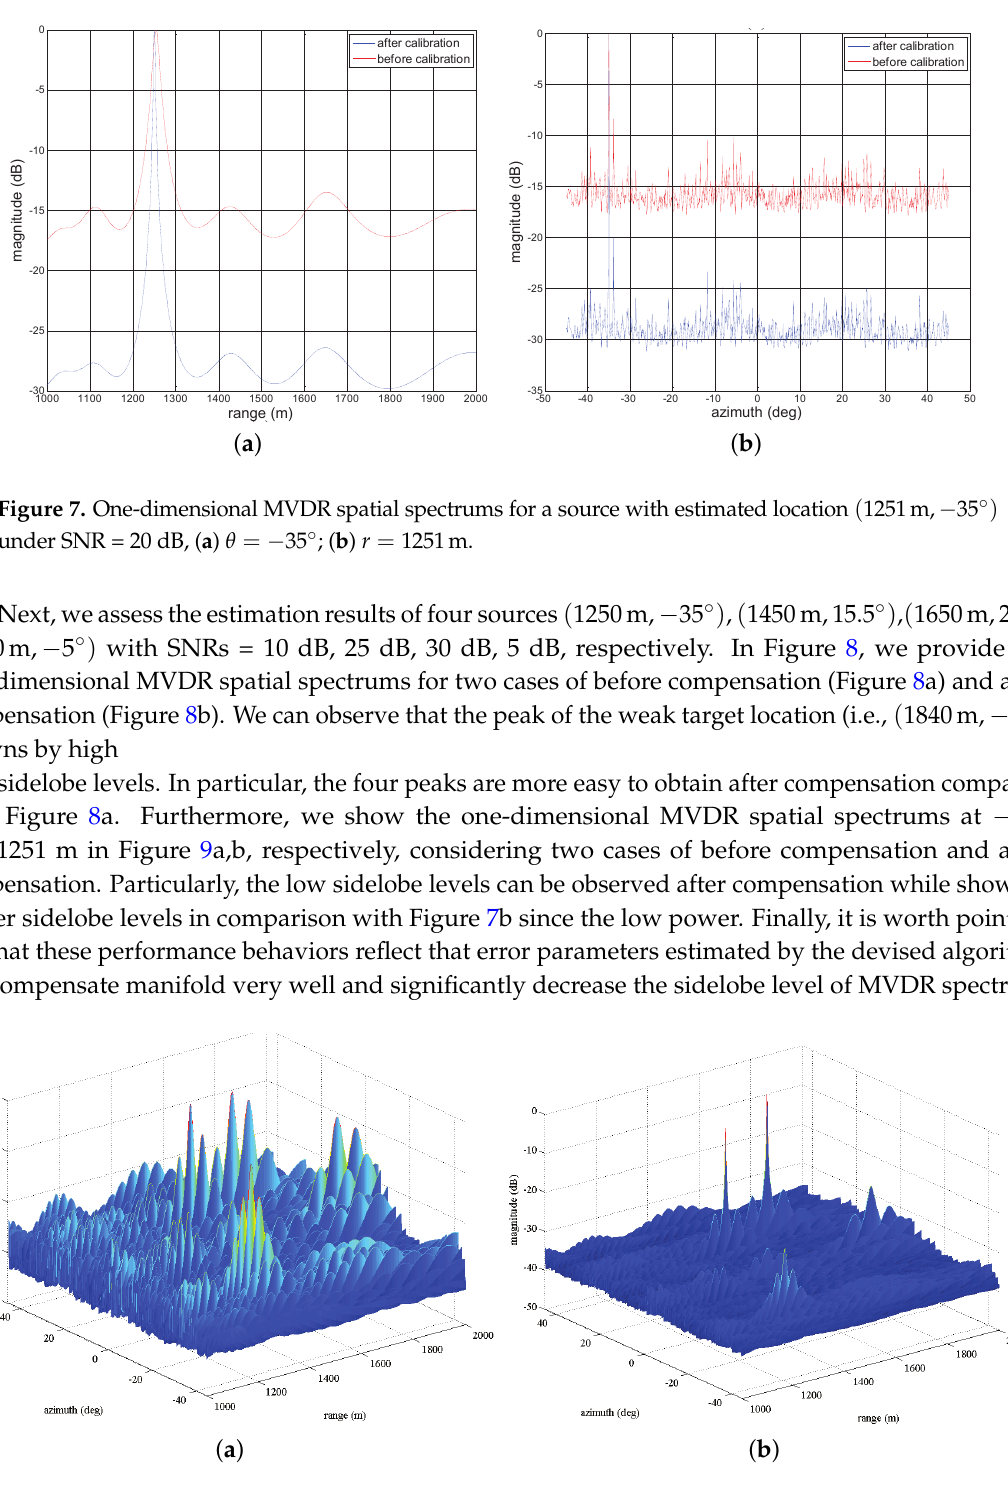
Figure 8. Two-dimensional MVDR spatial spectrums for four sources with different SNRs, ( a ) before calibration; ( b ) after